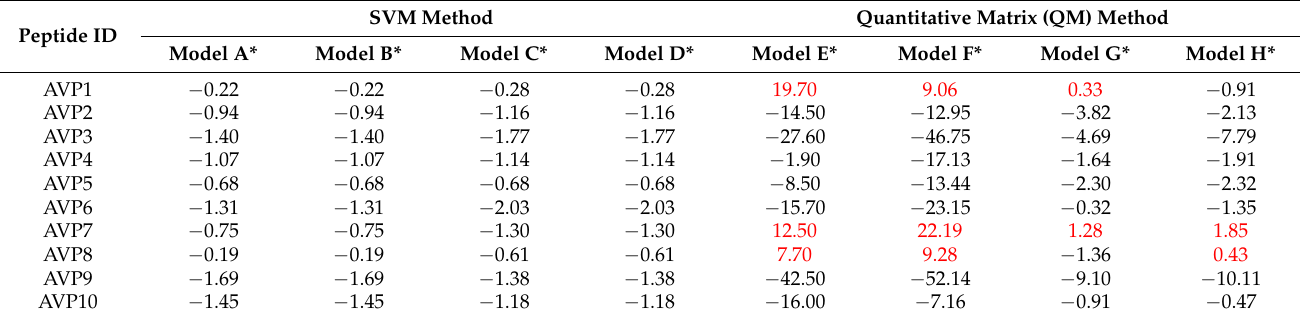
Table 5. Predictive SVM and QM scores from